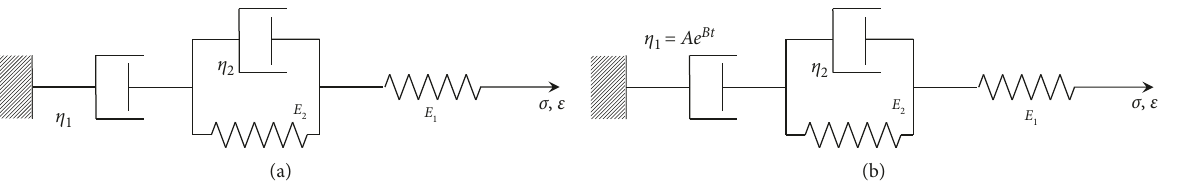
Figure 1: Schematic diagrams of (a) the Burgers model and (b) the modified Burgers